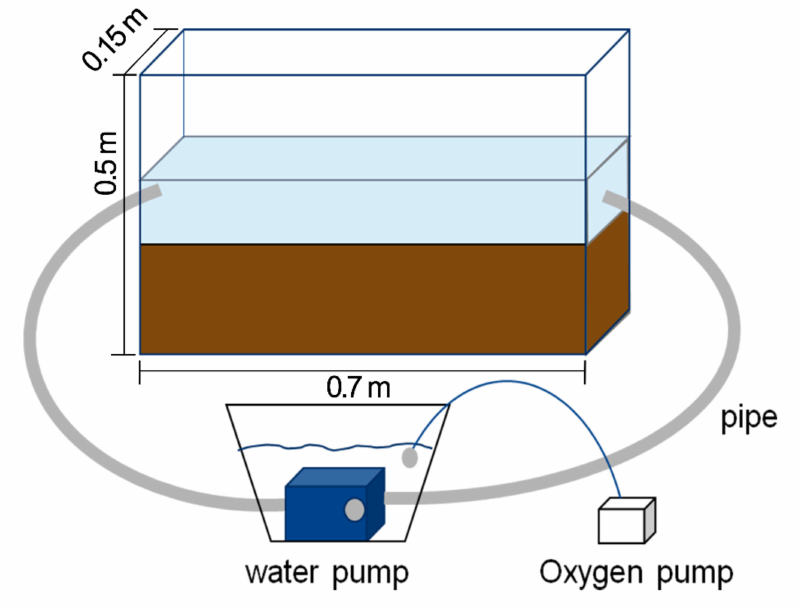
Figure 1. Single flume device designed in the